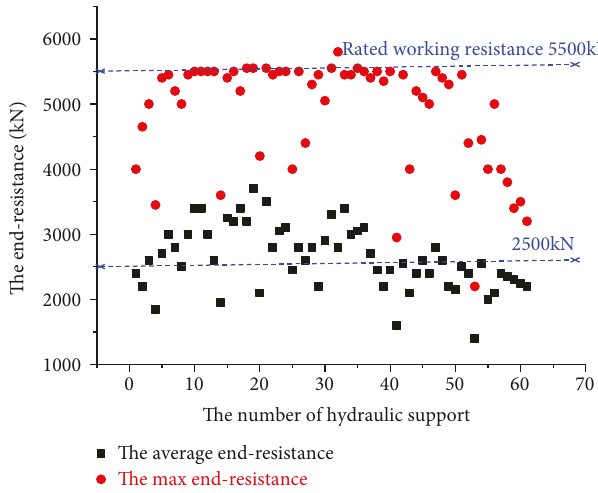
Figure 12: The circulation end resistance distribution of hydraulic supports.